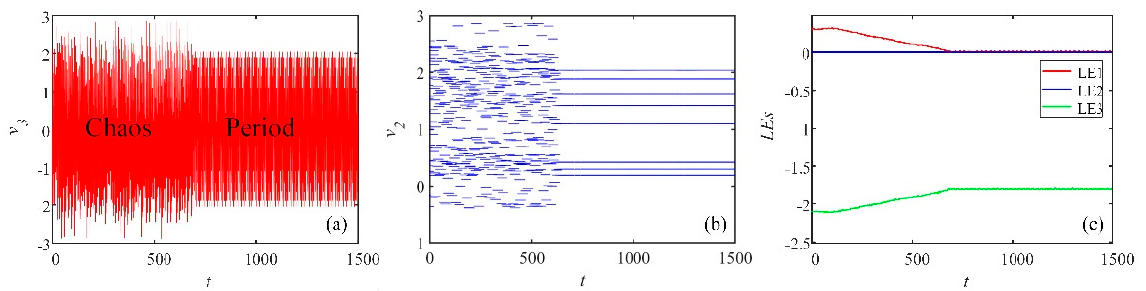
Figure 11. Transient chaos of the FOHNN system. ( a ) Time series of v 3 ; ( b ) Bifurcation evolving model; ( c ) Lyapunov exponents evolving model.